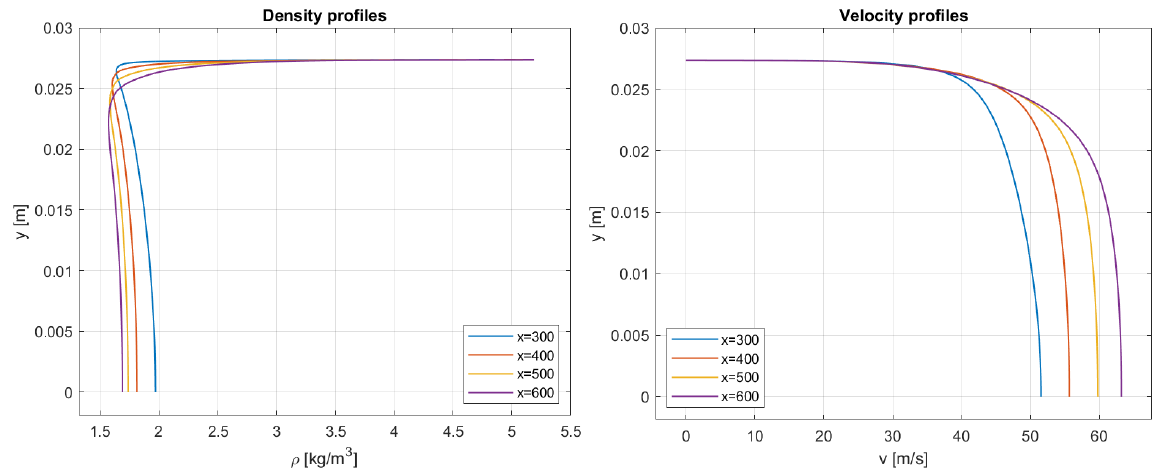
Figure 11. Density ( left ) and velocity ( right ) profiles for Test